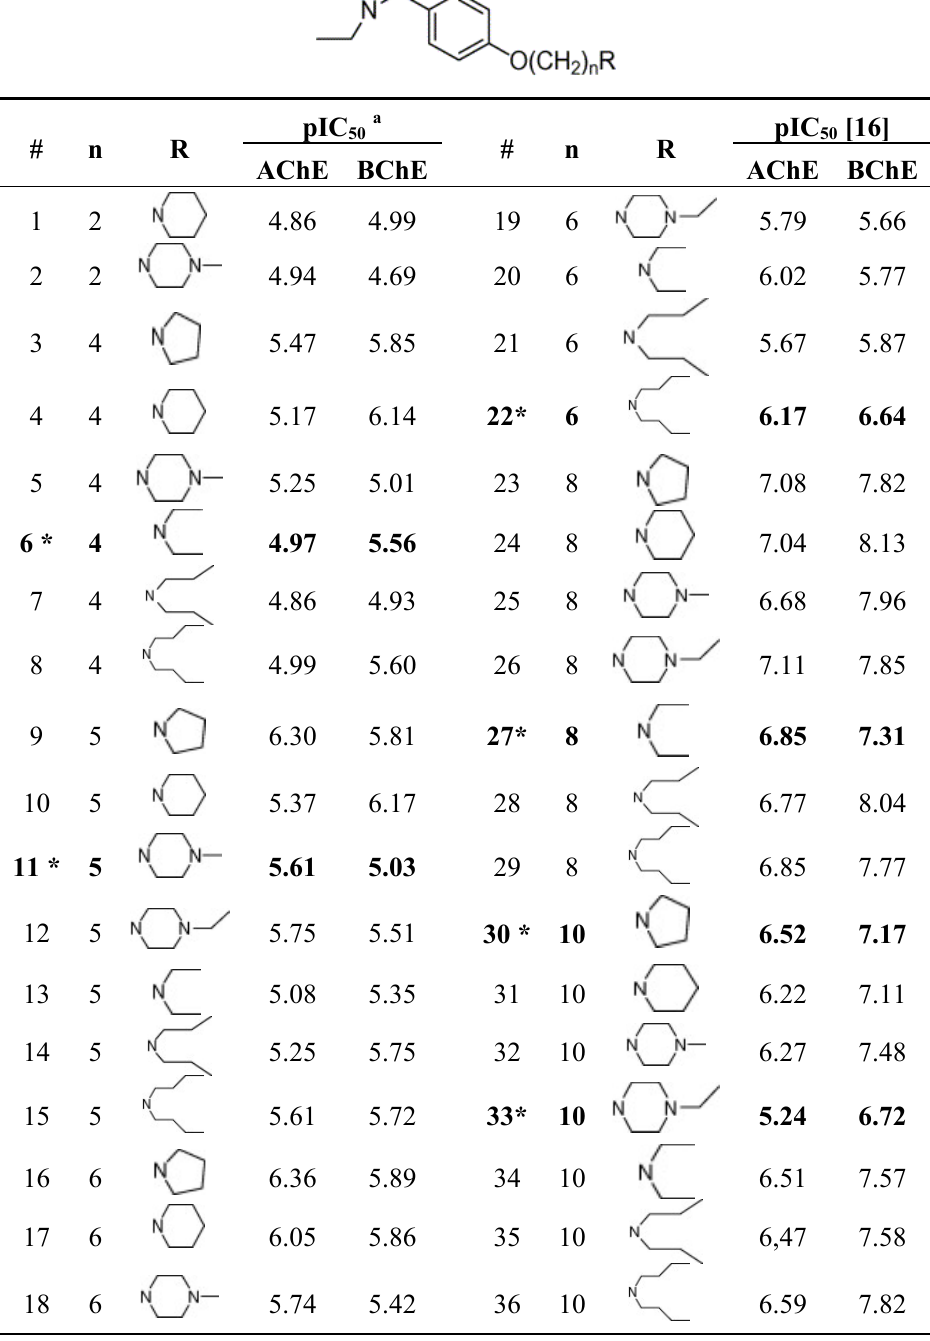
Table 1. Chemical structures and biological data (pIC